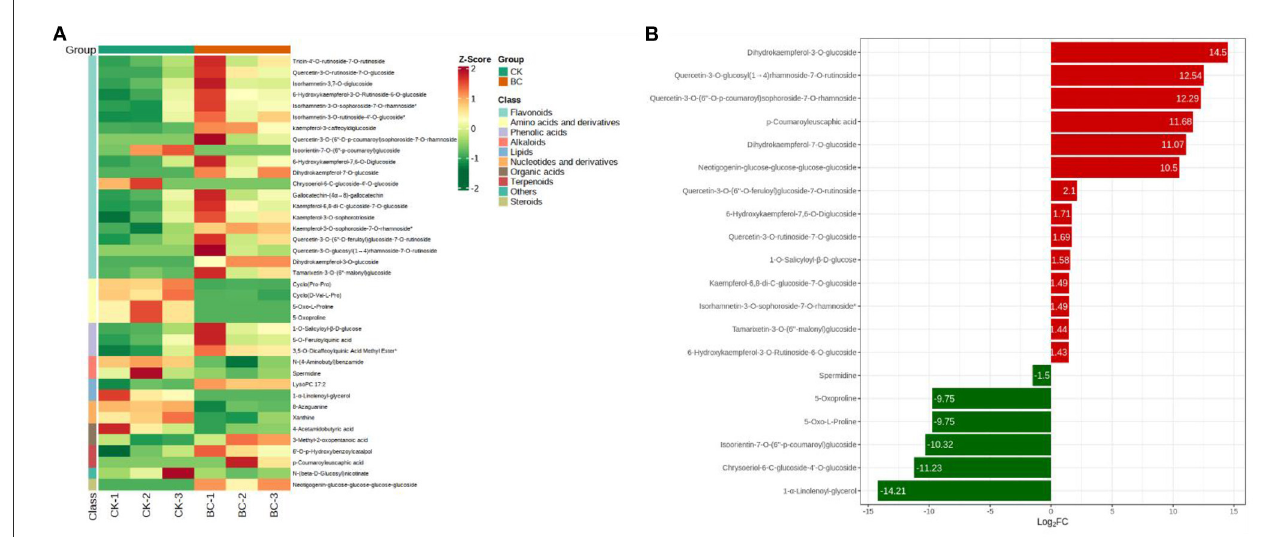
FIGURE4 Differential metabolome profile of tomato seedlings grown in CK (100% coconut bran) and BC (30:1 v/v coconut bran and bamboo charcoal). (A) Heatmap of the z-scores and (B) top-10 up- and down accumulated metabolites in CK vs. BC.